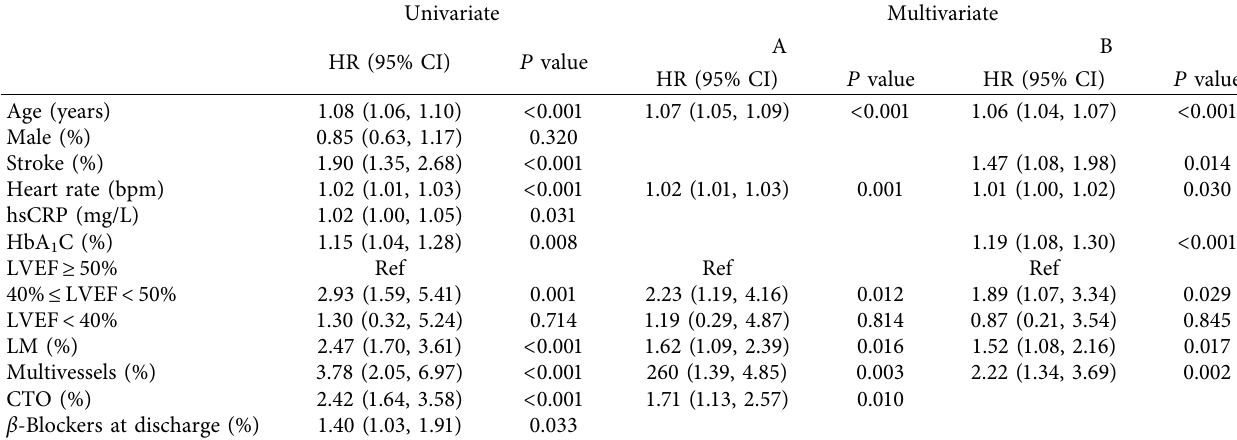
Table 6: Multivariate Cox regression analysis of secondary endpoints in propensity score matching